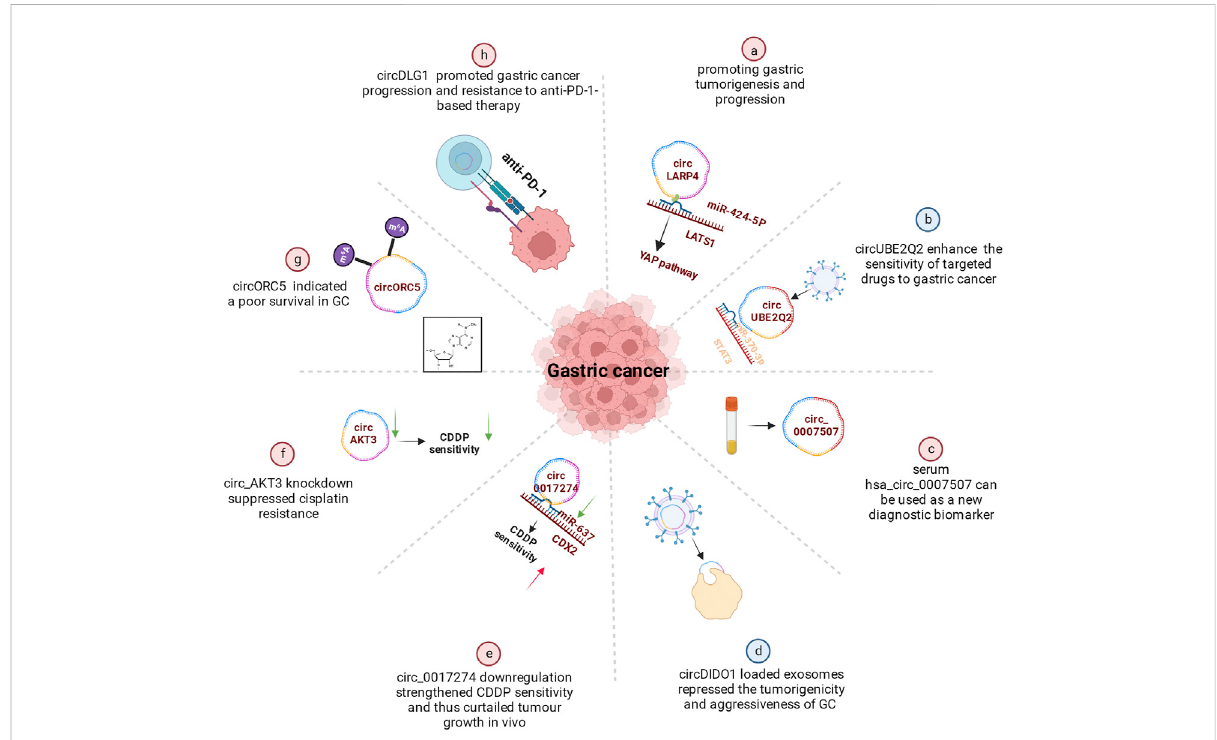
FIGURE 3 Functional roles of circRNAs in GC. (A) CircRNAs promoting gastric tumorigenesis and progression (e.g., circLARP4). A few circRNAs also regulated CDDP resistance (B) , cisplatin resistance (C) or promoted gastric cancer progression and resistance to anti-PD-1-based therapy (D) . (E) SomecircRNAs indicatedapoorsurvivalinGC(e.g.,circORC5). (F) Serumhsa_circ_0007507canbeusedasanewdiagnosticbiomarker. (G) Certain circRNAs could enhance the sensitivity of targeted drugs to gastric cancer (e.g., circUBE2Q2). (H) circDIDO1 could repressed the